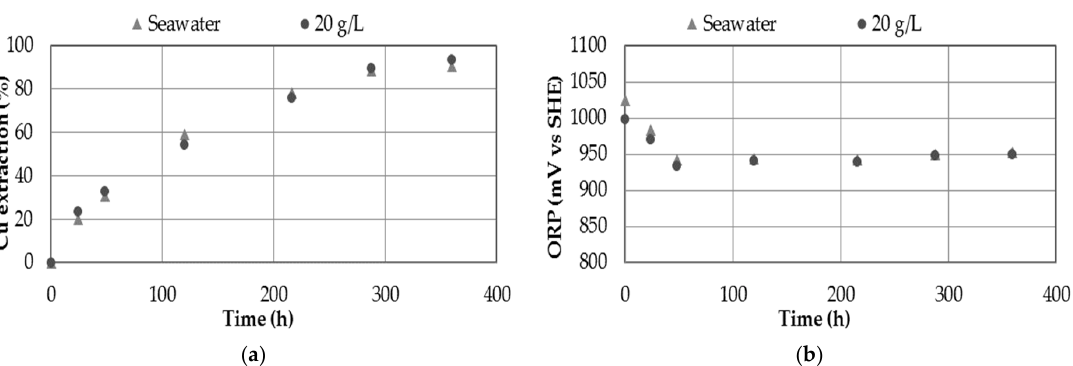
Figure 7. ( a ) Comparison of copper extraction (%) curve when seawater and water with 20 g / L Cl − were used as a source of water in the leach solution. ( b ) Redox potential (mV) versus time (h) when seawater and water with 20 g / L Cl − were used as a source of water in the leach solution. Experimental conditions: [NaNO 3 ] = [H 2 SO 4 ] = 0.7 M, 45 °C and sample A.